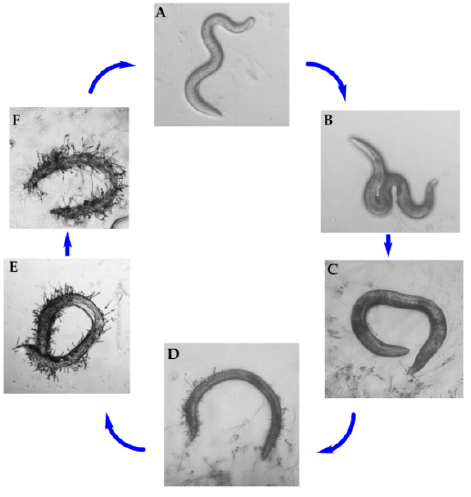
Figure 1. Pathogenicity process of D. coniospora YMF1.01759 against C. elegans .